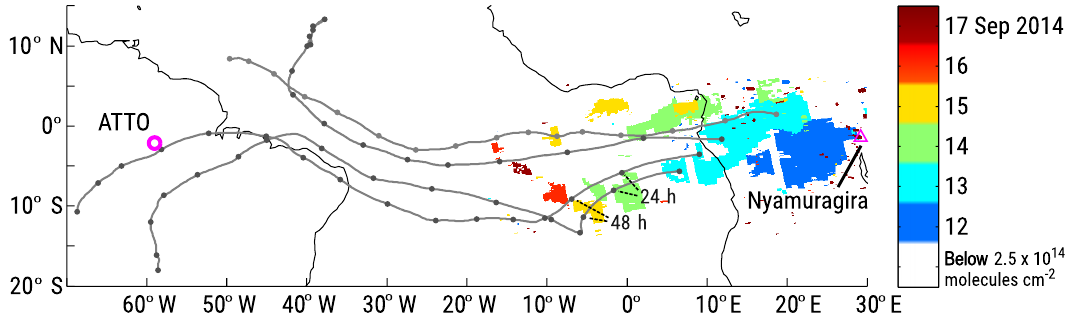
Figure 4. Map of SO 2 plumes with VCD>2.5 × 10 14 moleculescm − 2 color-coded by date of observation. The 15-day forward trajectories started at 4km (above mean sea level, a.m.s.l.) at four locations within the plume detected on 13 September 2014 (light blue) are indicated by black lines with markers at 24h